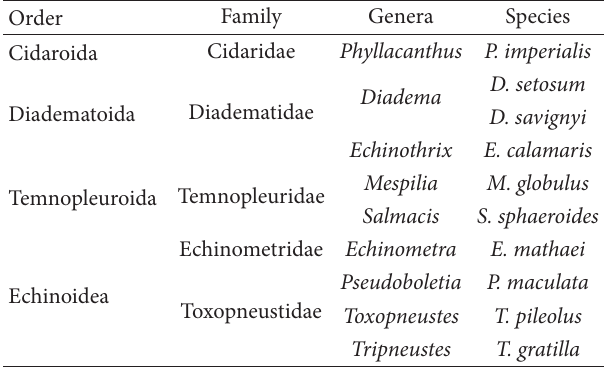
Table 2: The classification of sea urchin collected in Sabah. Order Family